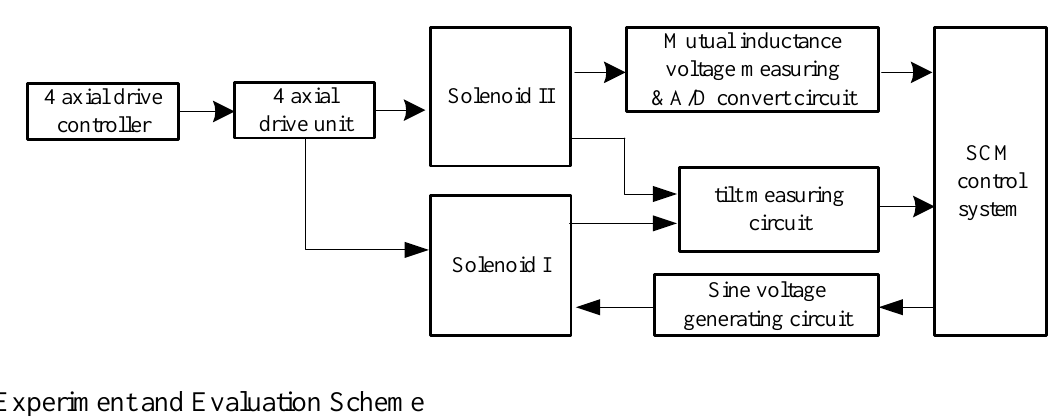
Figure 4. Schematic diagram of the experimental